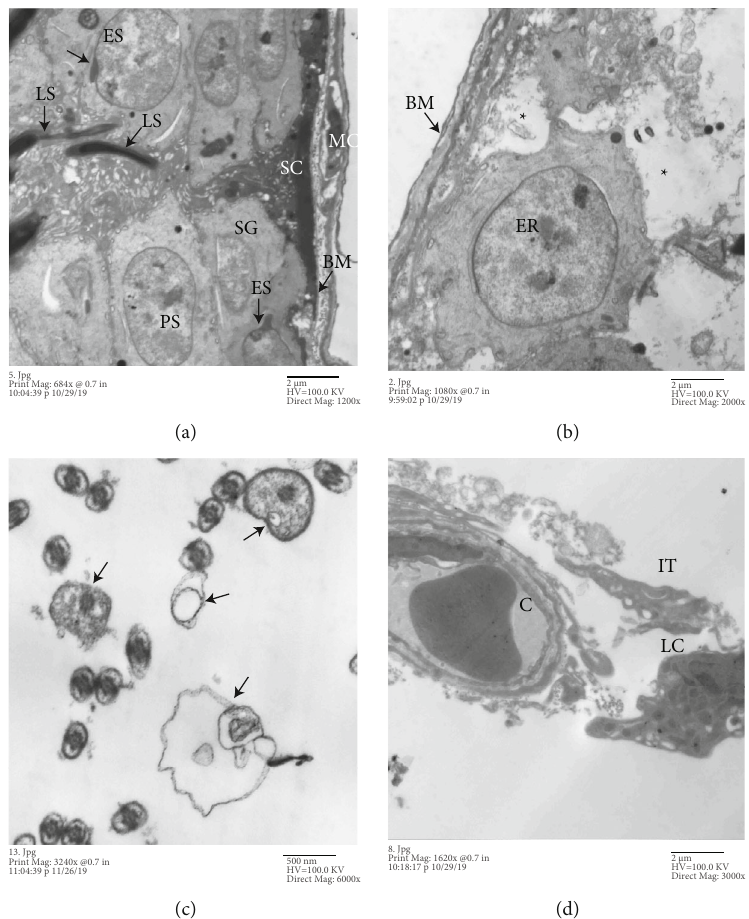
Figure 6: Electron micrographs of a seminiferous tubule of the MTX-treated group. (a) Distracted basement membrane (BM) with damaged myoid cells (MC), spermatogonia (SG) separated from the basement membrane, damaged Sertoli cells (SC) with a dark, shrunken nucleus, primary spermatocyte (PS), early spermatids (ES) with an abnormal acrosomal cap (arrowhead), and late spermatids (LS). (b) Necrosis and disappearance of certain stages of germ cells with cellular debris, widening of intercellular spaces in between ( ∗ ) and loss of Sertoli cells, and early spermatid (ER) with an acrosomal cap. (c) Transverse sections of distorted and malformed sperms in the lumen of the seminiferous tubules (arrows). (d) Abnormal wide interstitial tissue (IT) with degenerated Leydig cell (LC) and blood capillary(C) ((a): TEM, × 1200; (b): × 2000, (c): × 6000; and (d):